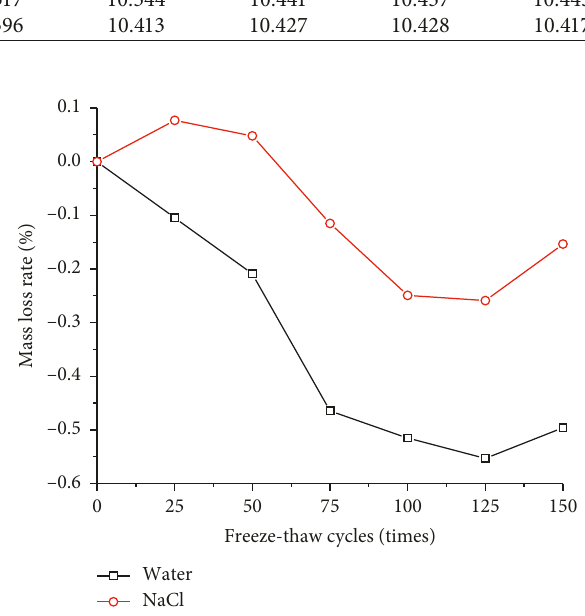
Figure 6: Mass loss rate of the test beam.